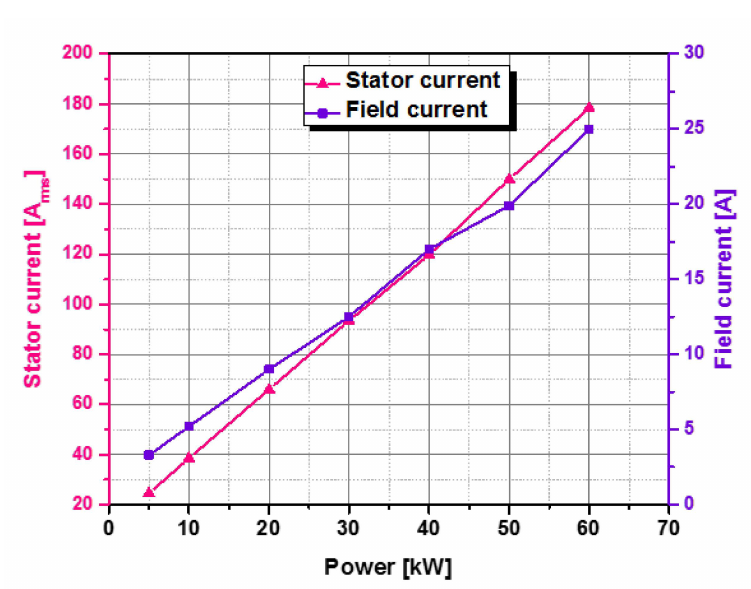
Figure 17. Efficiency vs. speed.